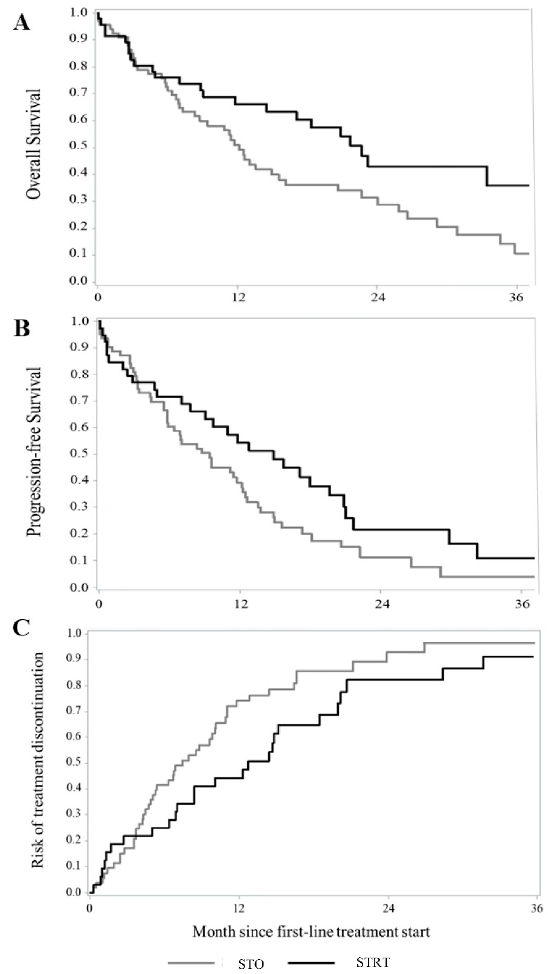
Figure 2. Kaplan–Meier estimates of overall survival ( A ), progression-free survival ( B ), and time- to-treatment failure ( C ) among patients with advanced NSCLC and synchronous brain metastasis treated with systemic therapy and advanced radiotherapy (STRT) or with systemic therapy only (STO). Footnote: In order to avoid immortal-time bias, in this analysis, only patients who survived to the first three months of follow-up were included. For each patient, follow-up starts three months after the start of first-line systemic